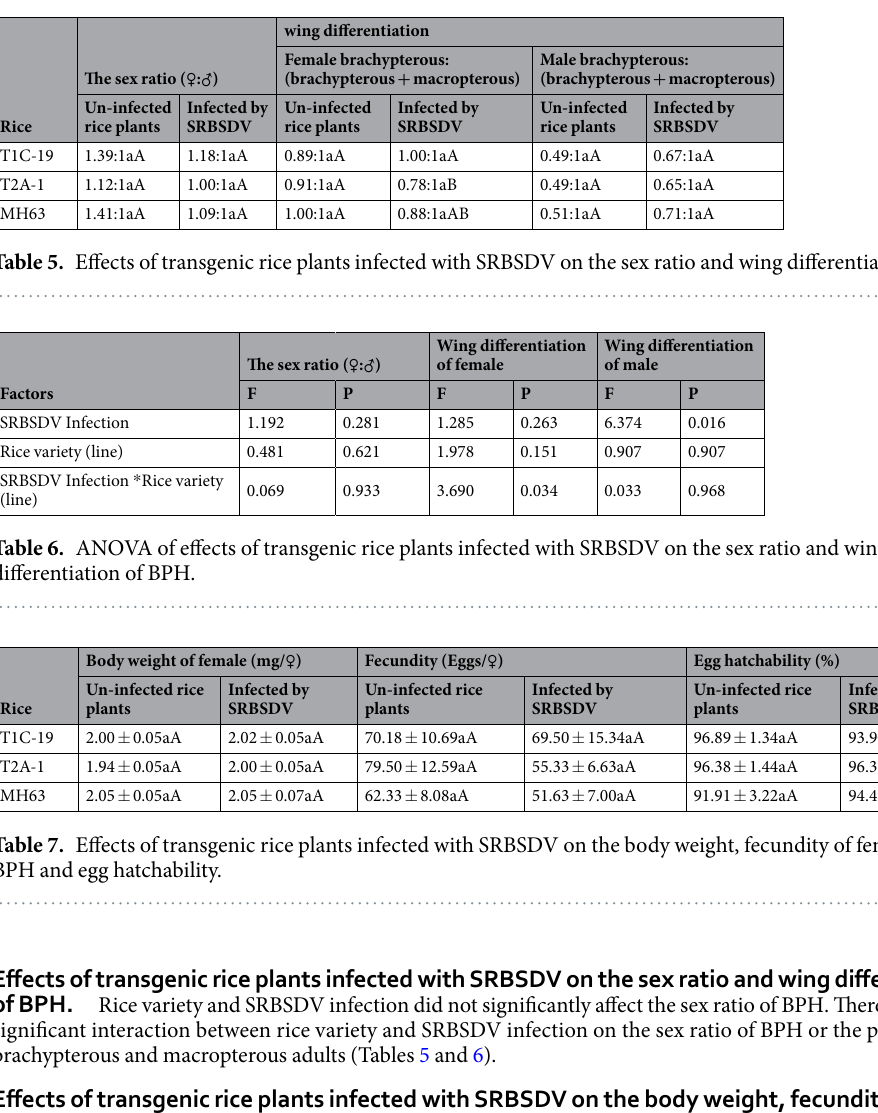
(Table 7). Variance analysis showed no significant interactions between rice variety and SRBSDV infection on the body weight, fecundity of female adults, or egg hatchability (Table 8).